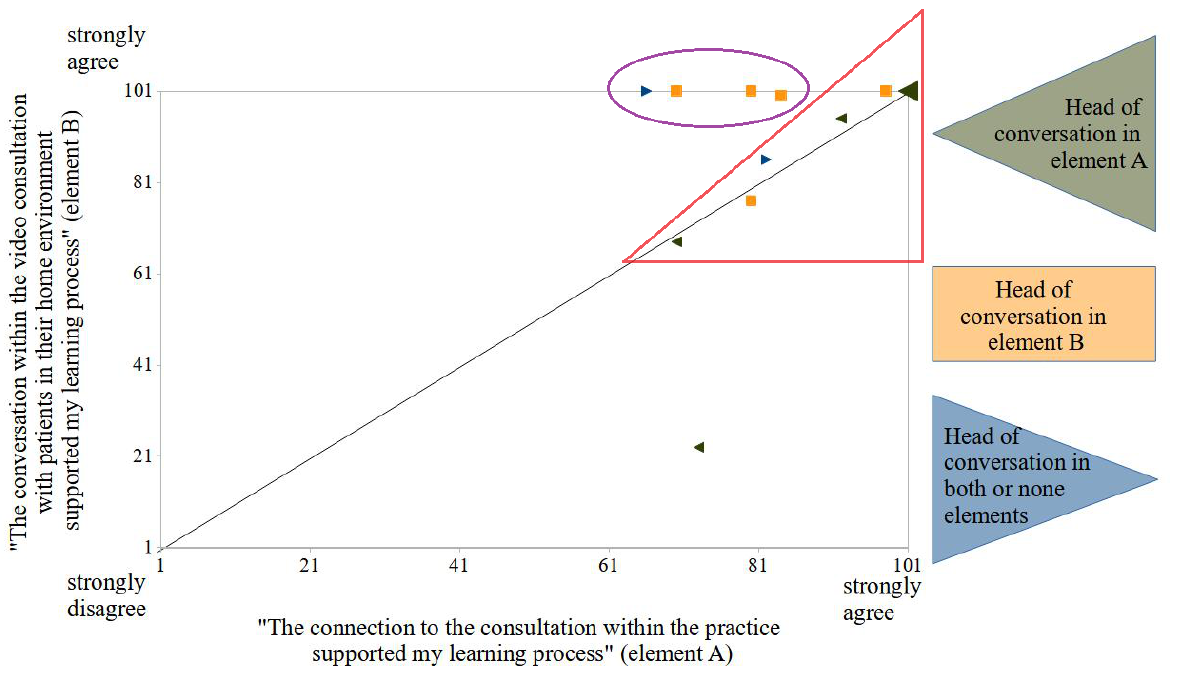
Figure 5. Correlation of two 101-point Likert scales to the following statements: “The connection to the consultation within the practice supported my learning process” and “The conversation within the video consultation with patients in their home environment supported my learning